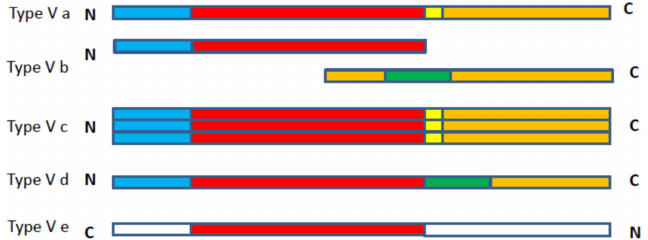
Figure 1. Scheme presenting domain organization among the subclasses of type-V bacterial autotransporter proteins. The labeling includes the conserved domains, colored blocks correspond to: Signal peptide (blue), passenger domain (red), polypeptide transport associated (POTRA) domain (green), linker domain (yellow) and translocation domain (orange). Adapted from